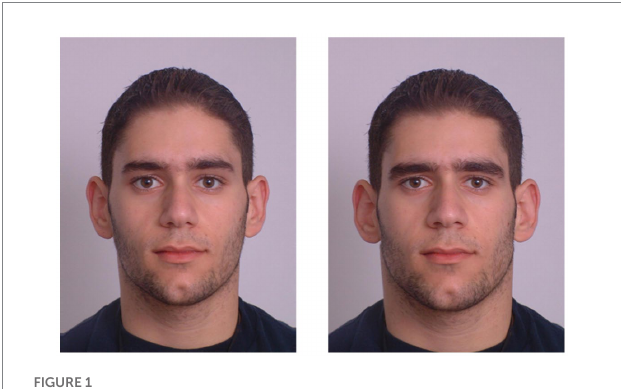
FIGURE 1 Presentation of a male face depicting a femininized (left) and masculinized (right) version. Reproduced with permission from Lisa DeBruine. Available at: https://figshare.com/articles/dataset/Young_